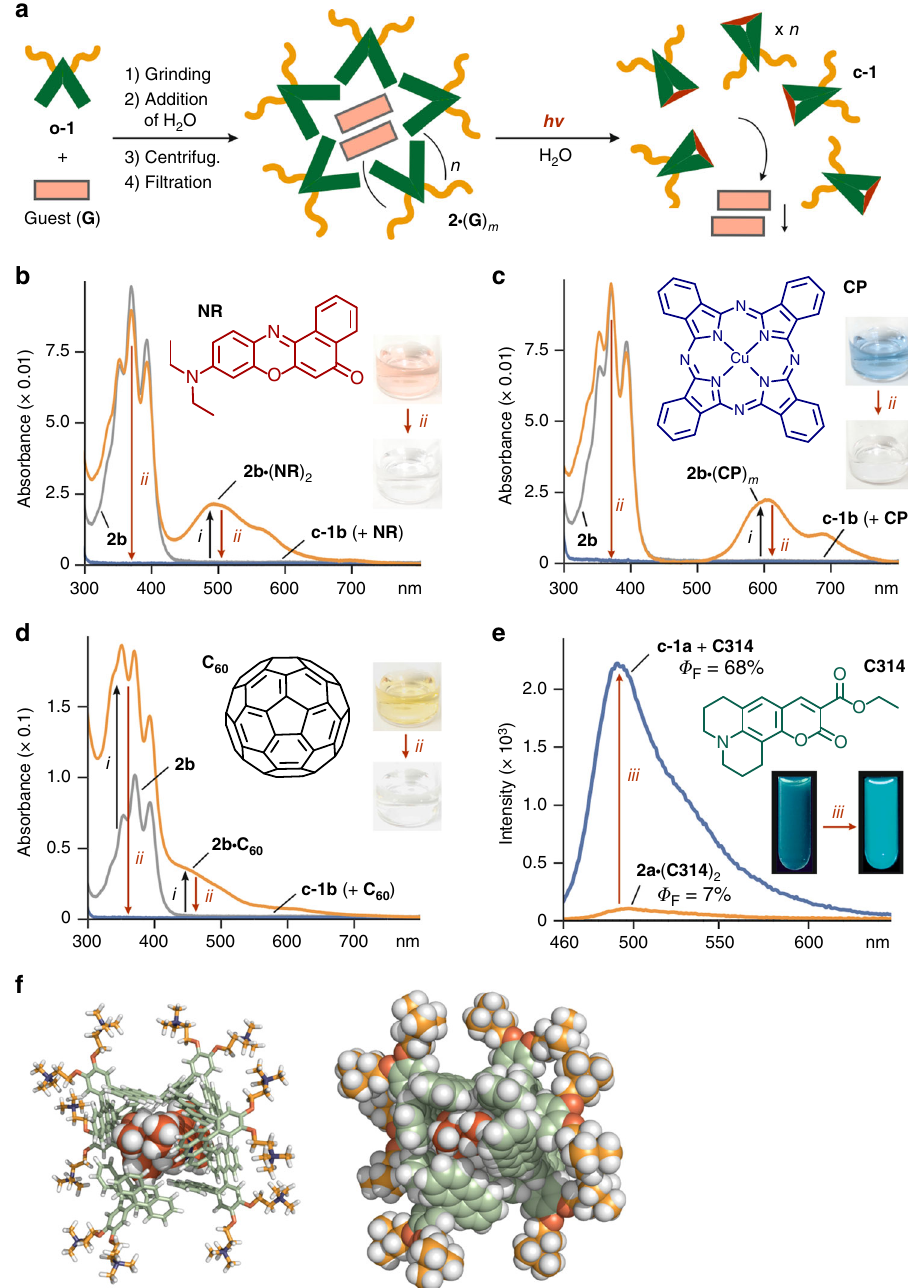
Fig. 5 Uptake and release of hydrophobic guests by the nanocapsule in water. a Schematic representation of the uptake and release of hydrophobic guests ( G ) using photoresponsive nanocapsule 2 . UV-visible spectra (H 2 O, room temperature, 0.1 mM based on o-1b ) and photographs of 2b ( i ) after uptake of b NR , c CP , and d C 60 and ( ii ) subsequent light irradiation of the corresponding products at 380 nm for 10 min. e Fluorescence spectra (H 2 O, room temperature, 1.0 mM based on o-1a , λ ex = 445 nm), fl uorescence quantum yields, and photographs ( λ ex = 470 nm) of 2a (cid:129) ( C314 ) 2 before and after ( iii ) light irradiation at 380 nm for 6.5 min. f Optimized structure of 2b (cid:129) ( NR ) 2 , in which stacked ( NR ) 2 are surrounded by six molecules of of fl ight (TOF) mass spectrometry (MS): Bruker Ultra fl eXtreme, electrospray ionization (ESI)-TOF MS: Bruker microTOF II, Fourier transform infrared (FT-IR): SHIMADZU IRSpirit-T, Particle Size Analysis (DLS): Wyatt Technology DynaPro NanoStar, AFM: Asylum Reseach Cypher S, UV-visible: JASCO V-670DS, Emission: Hitachi F7000, Absolute PL quantum yield: Hamamatsu Quantaurus-QY C11347 – 01, Microwave Reactor: Biotage Initiator + , Lyophiliza- tion: Eyela Desktop Freeze Dryer FD-1000. Optimized structure: Accelrys Software Inc., Materials Studio, FORCITE module (version 5.5.3). Solvents and reagents: TCI Co., Ltd., Wako Pure Chemical Industries Ltd., Kanto Chemical Co., Inc., Sigma-Aldrich Co., and Cambridge Isotope Laboratories, Inc. Transfer of liquids with a volume ranging from 10 to 100 μ l or from 100 to 1000 μ l was performed